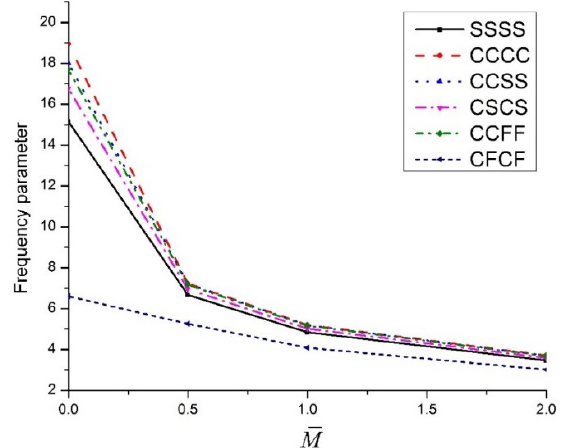
Figure 3. The variation of dimensionless frequency parameter vs. dimensionless concentrated mass for an FG-CNT-reinforced plate for various boundary conditions.